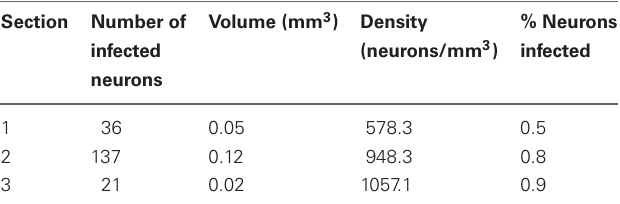
Table 2 | Summary of GFP expression for the first injection site in monkey V.